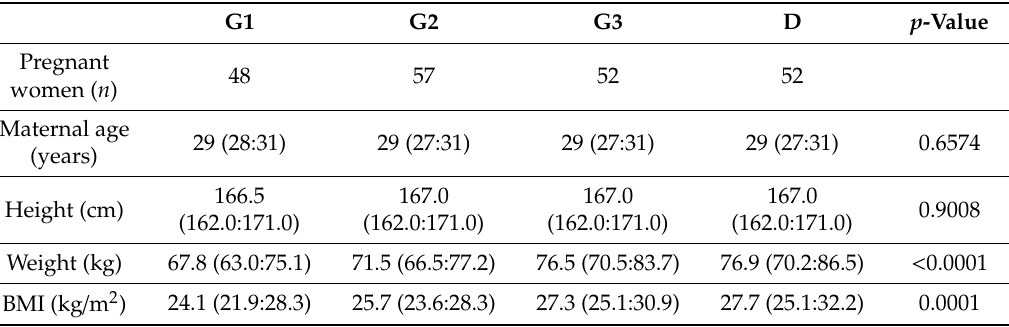
Table 1. Characteristics of pregnant women.